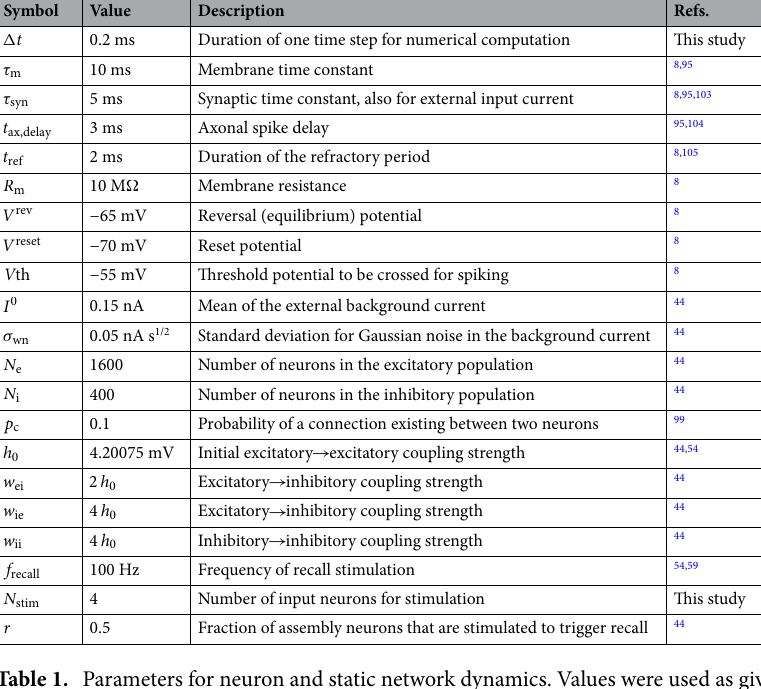
Table 1. Parameters for neuron and static network dynamics. Values were used as given in this table, unless stated otherwise.